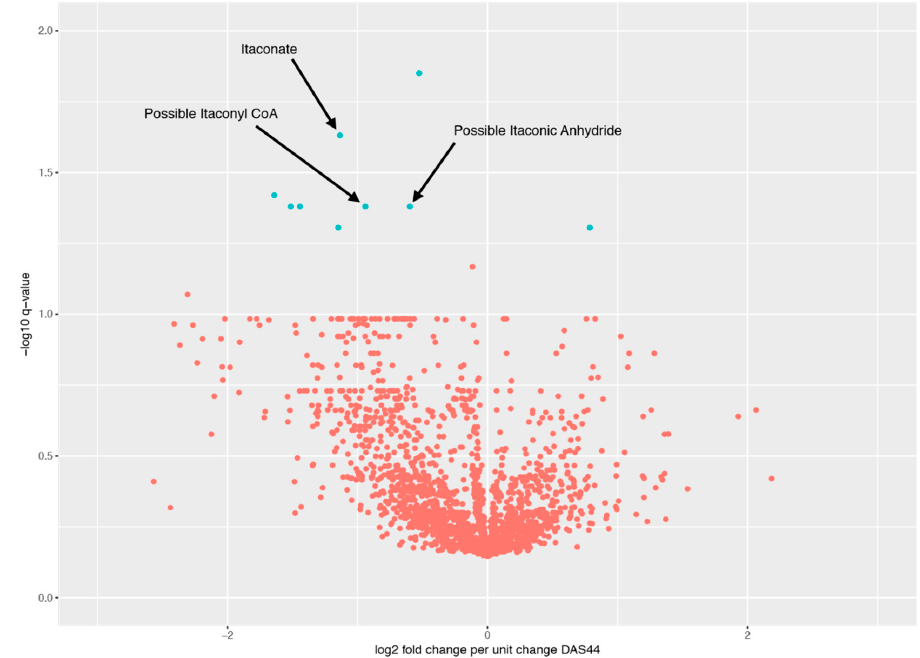
Figure 1. Volcano plot between baseline and three months. Blue points are significant peaks; orange points are not significant peaks. Table 2. Annotated LC-MS peaks that have been di ff erentially expressed across changing DAS44